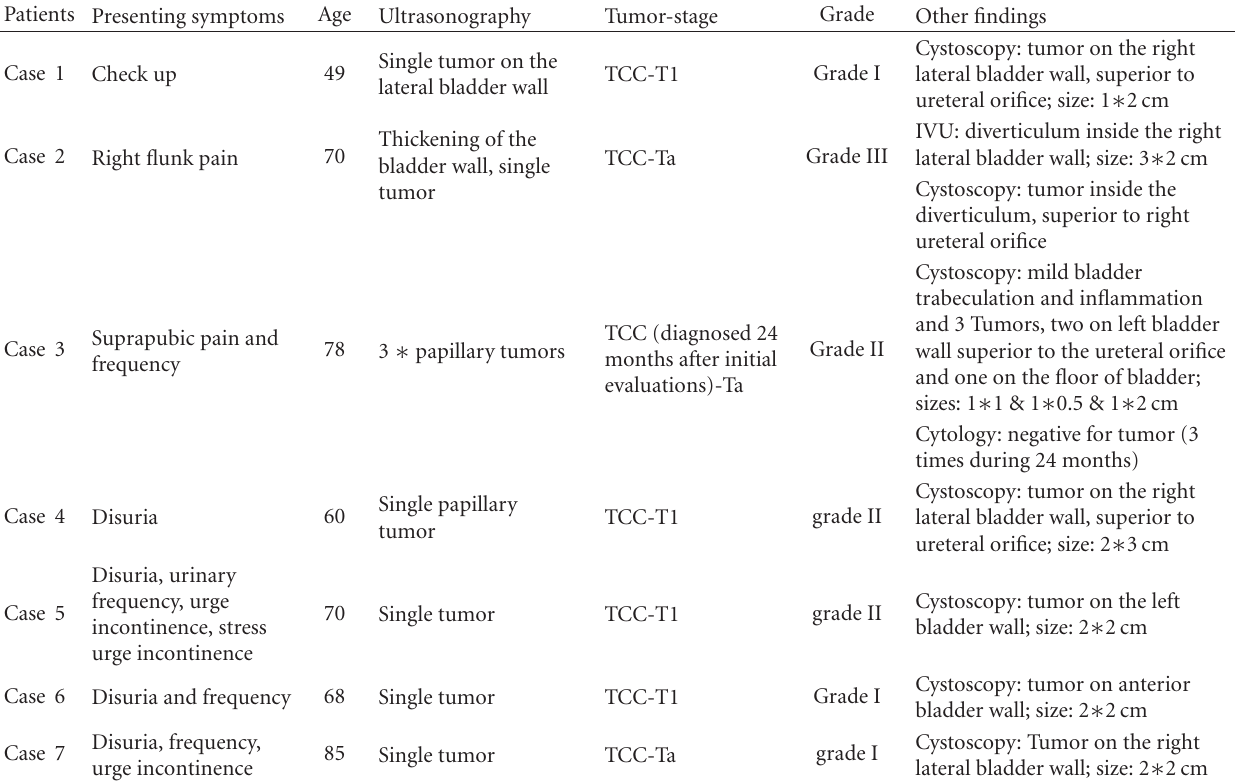
Table 1: Characteristics of patients with confirmed diagnosis of bladder